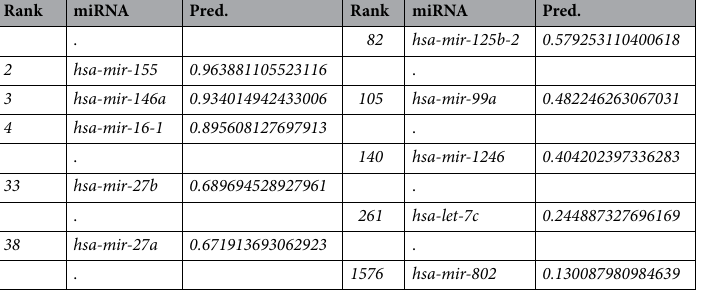
Table 6. MPM ’s average prediction scores for Down Syndrome and all 1618 miRNAs. The associated miRNAs are marked as italics. The model training data does not contain the association data for Down Syndrome .